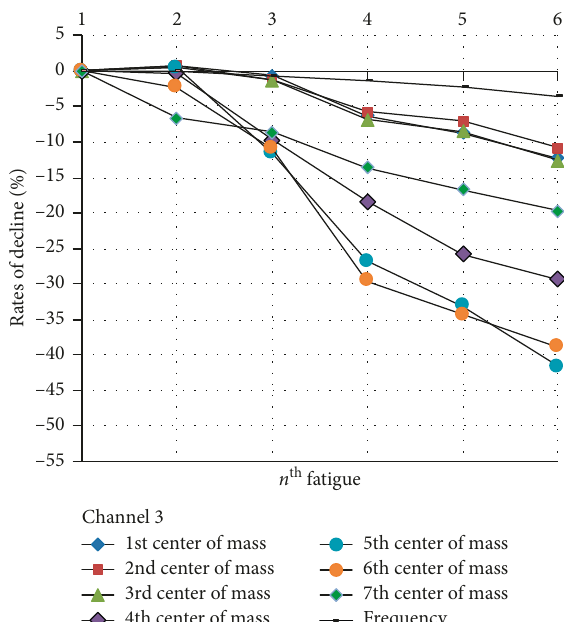
Figure 22: The declined rates in channels 3 with 7 central points in 4 fatigue